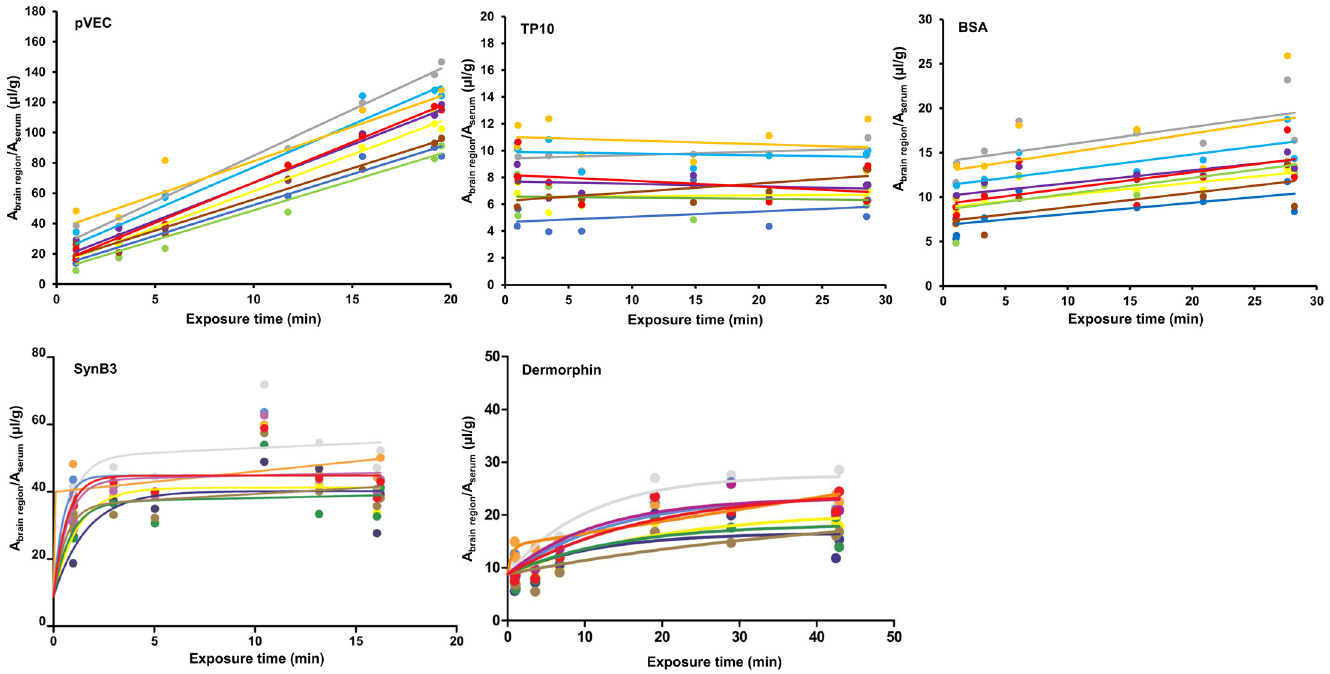
Fig 4. Regional variations in brain influx of pVEC, TP10, SynB3, dermorphin and radioiodinated BSA. The data of pVEC, TP10 and radioiodinated BSA are fitted using the linear Gjedde-Patlak model; the data of SynB3 and dermorphin are fitted using the biphasic model. Grey = whole brain, yellow = frontal cortex, purple = occipital + parietal cortex, light blue = cerebellum, dark blue = striatum, brown = thalamus + hypothalamus, orange = pons medulla, green = hippocampus and red = midbrain.